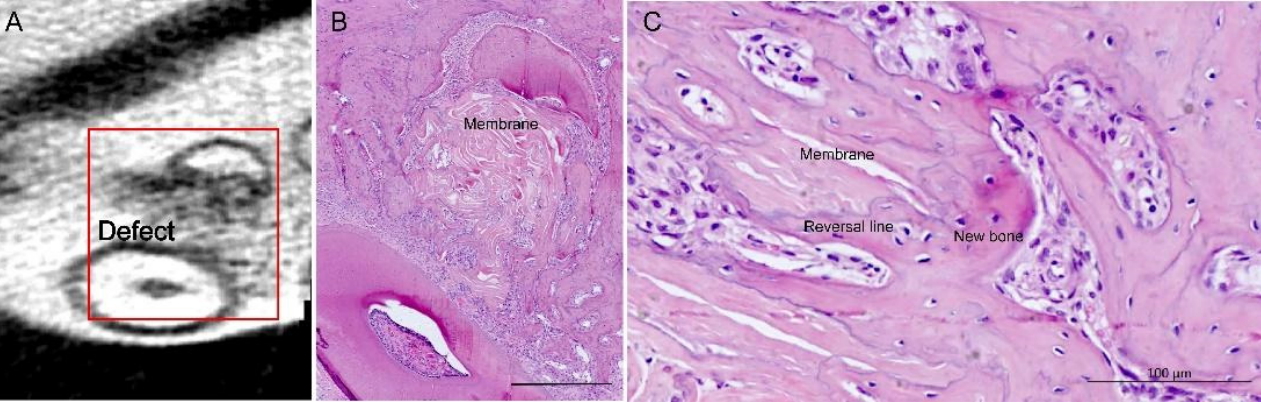
Figure 3. Healing of a defect in a right maxillary molar furcation defect, transplantation of decellularized amniotic membrane associated with undifferentiated adipose-derived stromal cells (T2). Micro-computed tomography image of bone healing between the two molar roots ( A ). Histological section of the same rectangular area in ( A ), with membrane filling the defect between dental roots, orientating bone deposition; in B, osteoconduction by the decellularized membrane and in C demonstrated by vascularization between the membrane folds and distinctive, purple-stained reversal line delineating new bone deposition on loose collagenous fibers of the grafted membrane. H&E stain ( B , C ); scale bars 1 mm ( A ), 500 µ m ( B ), 100 µ m ( C ).